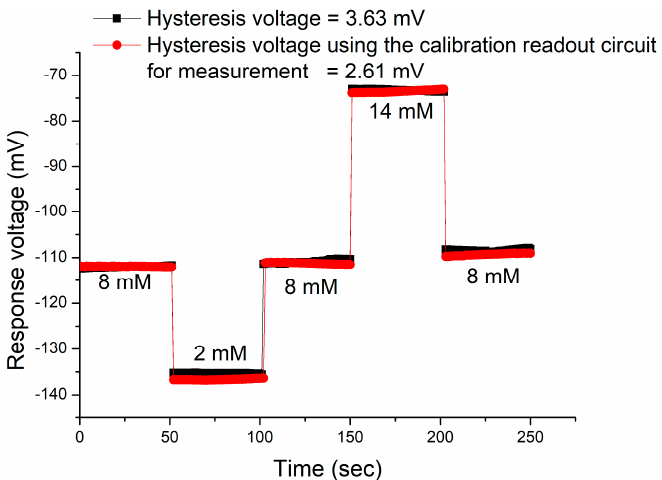
Figure 14. Hysteresis voltages of the AgNWs/CZO sensor by using the V-T measurement system and calibration readout circuit in the forward cycle.